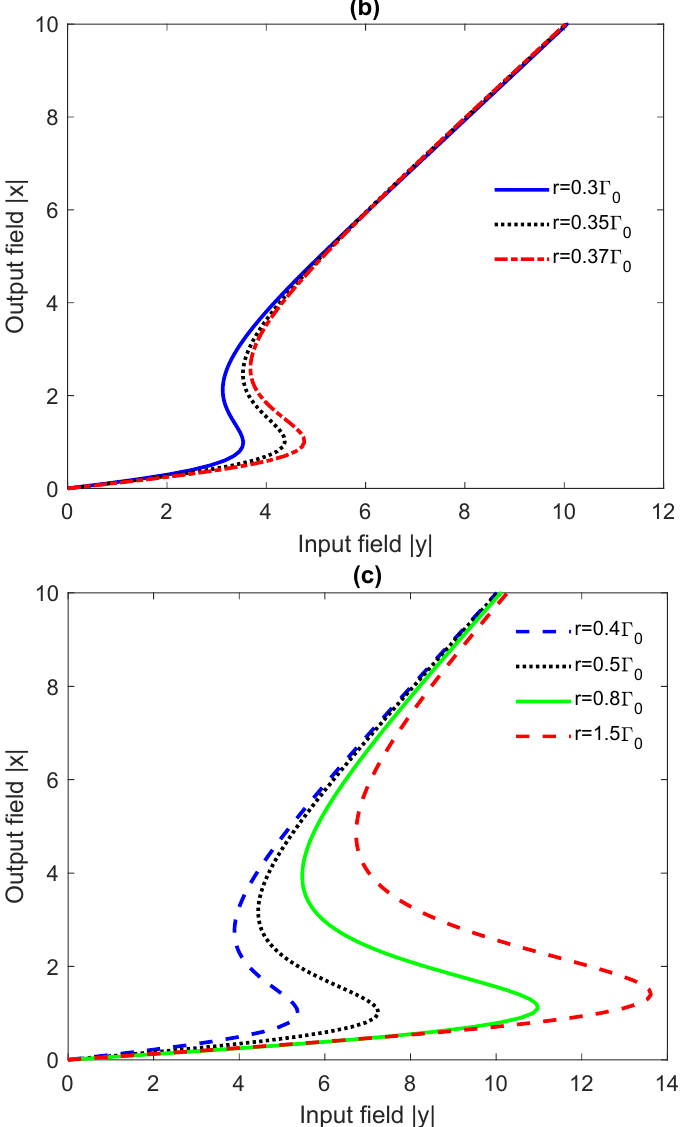
Figure 5. Plots of the input–output field curves for the quantum sample (emitter + metasurface) for various values of the distance d . In ( a ), the incoherent pumping rate r varies from 0 to 0.28 Γ 0 ; in ( b ), from 0,3 Γ 0 to 0.37 Γ 0 ; and, in ( c ), from 0,4 Γ 0 to 1.5 Γ 0 . We take ¯ ω = 0.632 ω p , ω 32 = Γ 0 , C = 100 and δ = 0.2 Γ 0 and d = 0.8 c / ω c